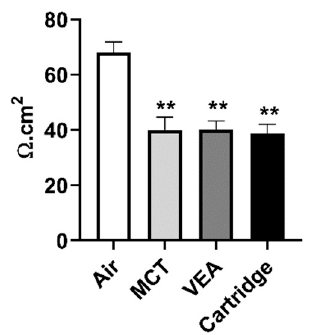
Figure 3. Barrier dysfunction caused by counterfeit vape cartridges in bronchial epithelial cells. 16-HBE cells were cultured on transwell inserts and exposed to 2 pu ff s of 70 mL of air, MCT, vitamin E acetate (50% w / v ), and counterfeit vape cartridge for 10 min. Twenty-four hours later, the resistance was measured by an EVOM2 device. One-way ANOVA ** p < 0.01 vs. air ( n = 3).